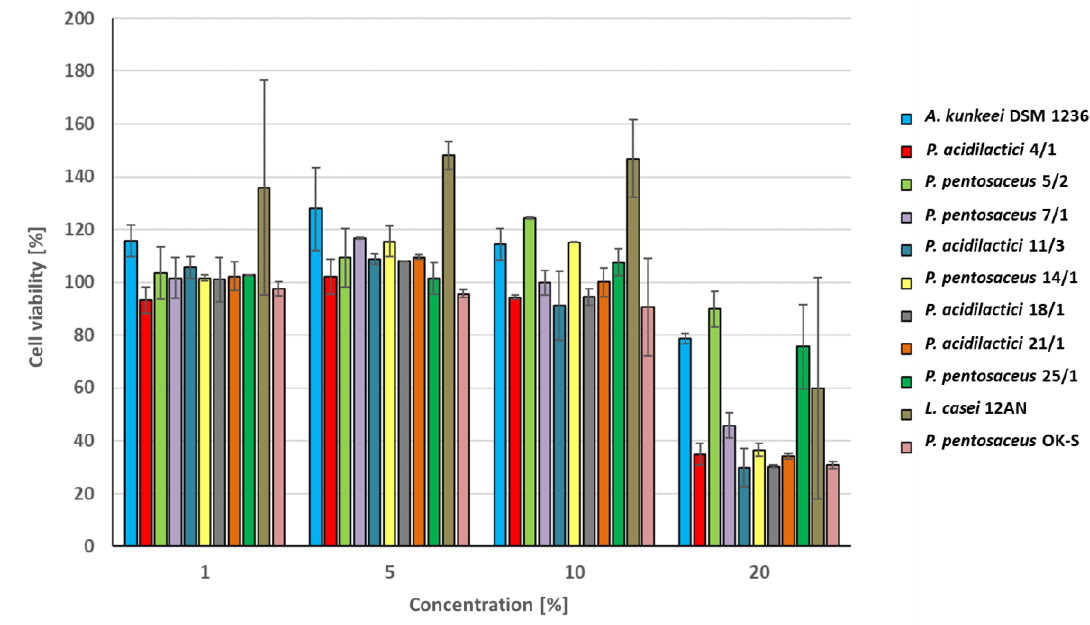
Figure 4. Survival of Caco-2 cells in the presence of cell-free culture supernatants from lactic acid bacteria (LAB). Results are presented as mean ± standard deviation. Results showing the statistically significant effect of metabolites produced by LAB on cell survival rate are presented in Tables S3 and S4 ( p < 0.05).